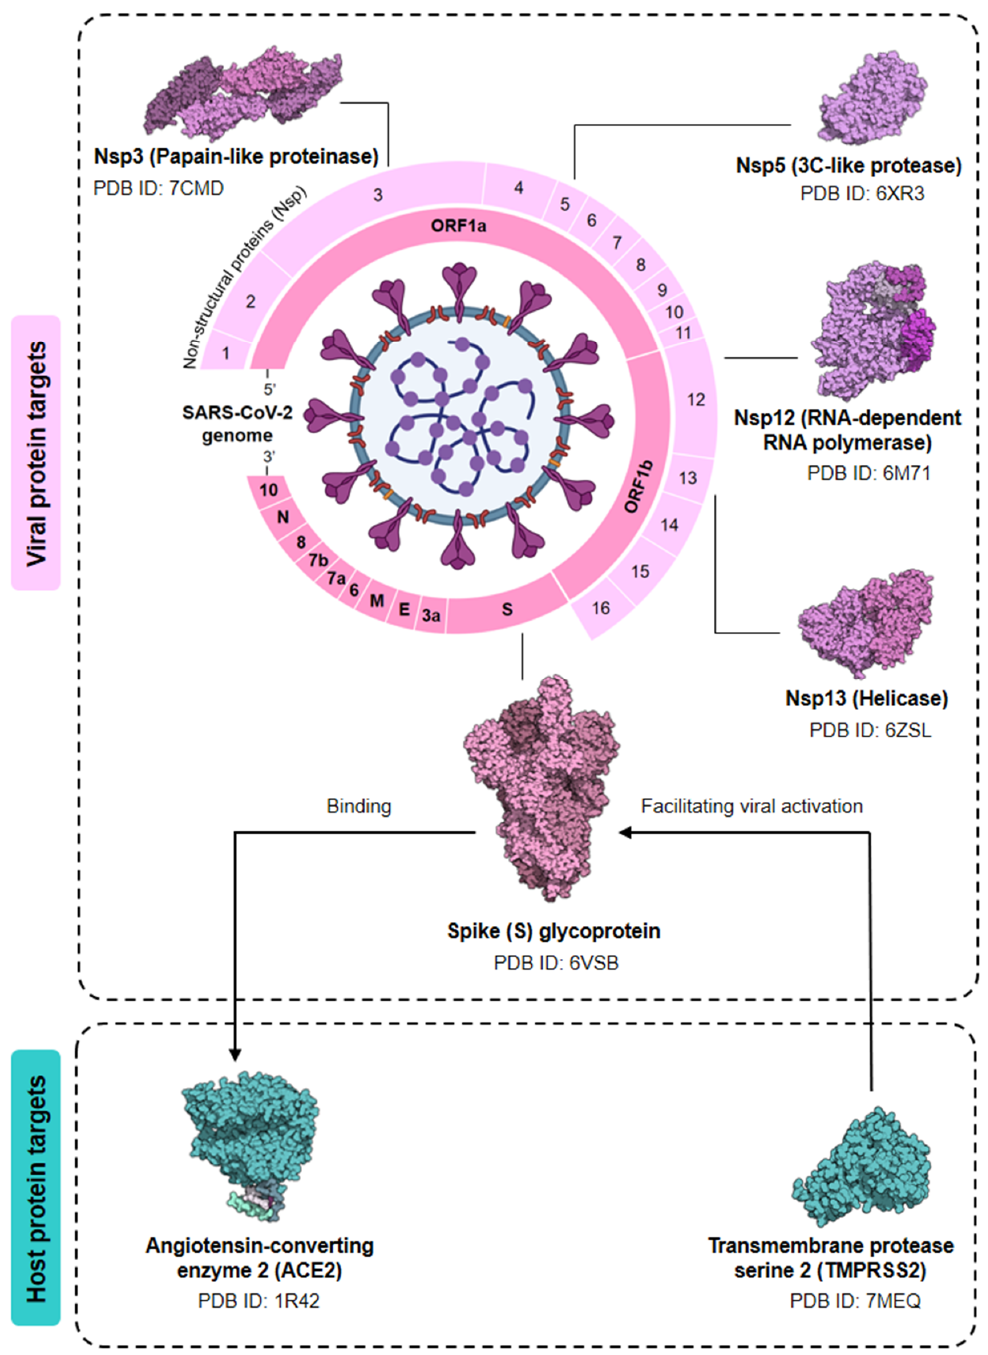
Figure 3. The structures of possible viral and host protein targets could be inhibited by probiotic metabolites to prevent SARS-CoV-2. Angiotensin-converting enzyme 2 (ACE2), which locates on host cells, is the primary cell entry receptor for SARS-CoV-2 [174]; transmembrane protease serine 2 (TMPRSS2), which facilitate viral activation, is a cell surface protein expressed in the respiratory and GI tract [175]. SARS-CoV-2 requires both ACE2 and TMPRSS2 for entry into cells [176]. Spike (S) protein involves mainly in the receptor recognition and viral entry of SARS-CoV-2 [177]; Papain-like proteinase (PL pro ) has an essential role in viral polyprotein cleavage and maturation [178]; 3C-like main protease (3CL pro ) plays a key role in control viral replication [179]; RNA-dependent RNA polymerase (RdRp), a viral enzyme, involves in viral RNA replication in host cells [180]; Nsp13 is a helicase requiring adenosine triphosphate (ATP) to translocate and unwind SARS-Cov-2 RNA [181] .